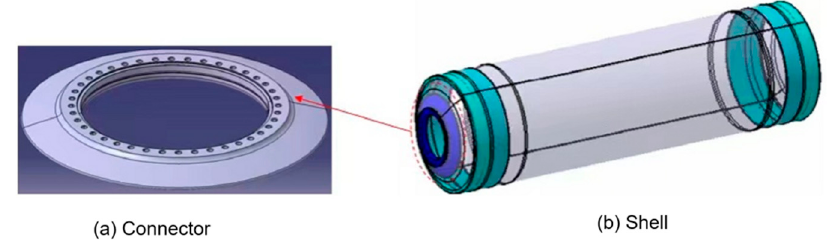
Figure 1. Schematic of SRMC connector and shell: ( a ) the connector to the shell body ( b ) the shell body of the rocket.